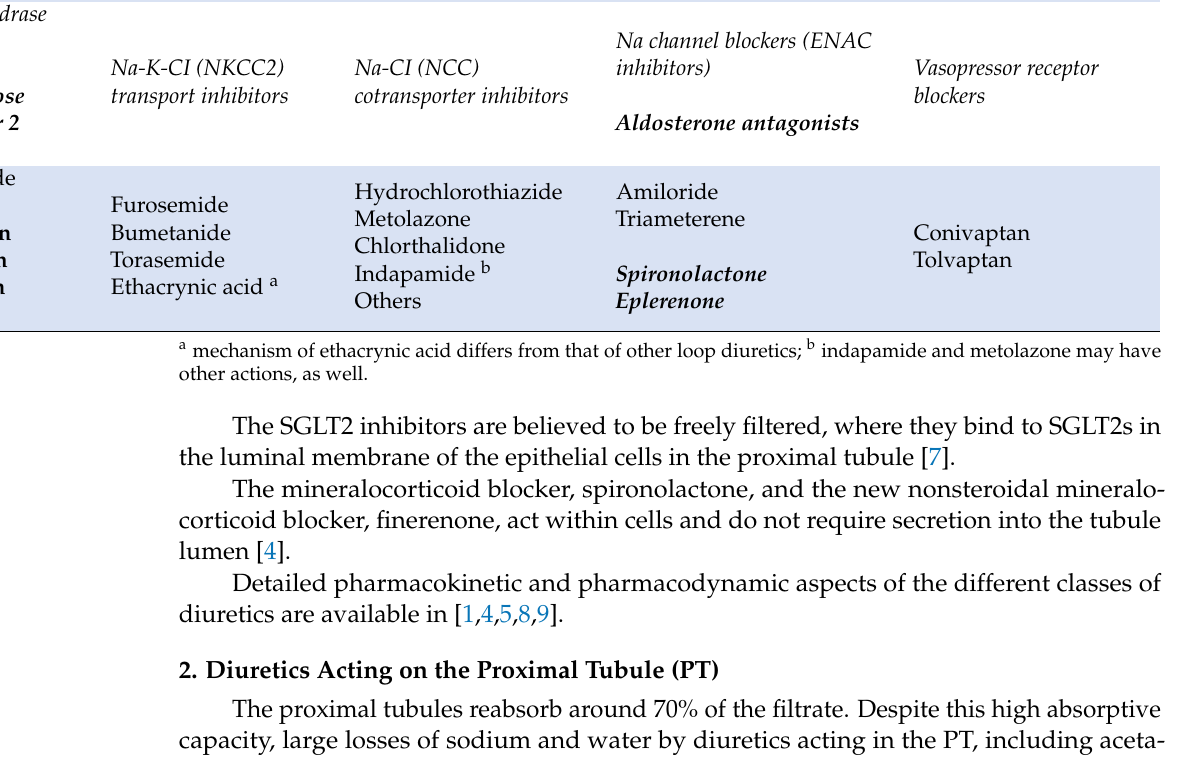
Figure 1. Schematic of a nephron shows sites of action of diuretics along the various segments. Adapted with permission from Ref. [1]. 2022, Elsevier. (DCT: distal convoluted tubule; CNT: connecting tubule). Table 1. Diuretics classified according to their localization and their mechanisms of action on the sodium and vasopressin transporters in the nephron. Adapted with permission from Ref. [5] 2022, Oxford Publishing Limited.